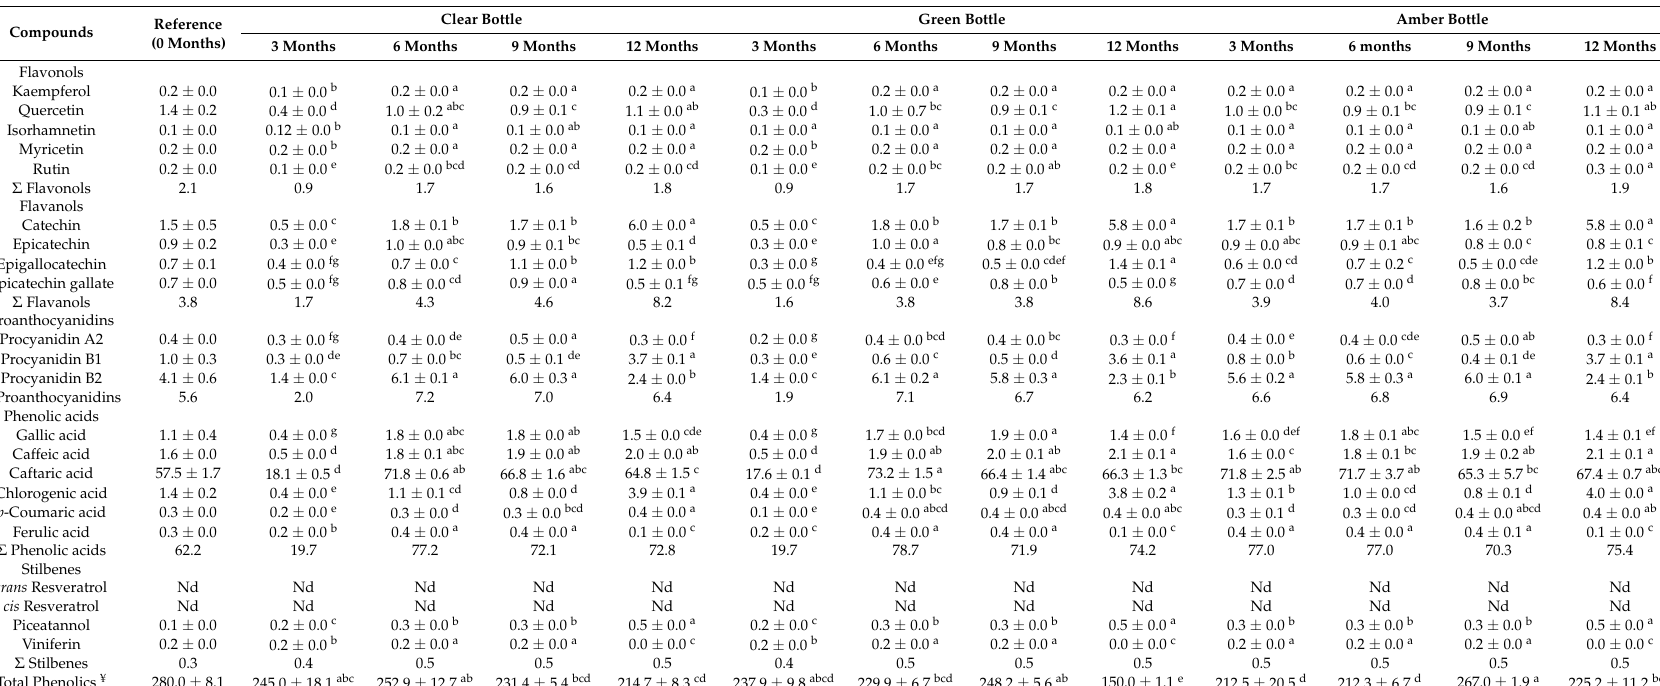
Table 3. Evolution of phenolic compounds (mg L − 1 ) (mean ± standard deviation) in the sparkling Moscatel stored in bottles of different colors for 12 months.